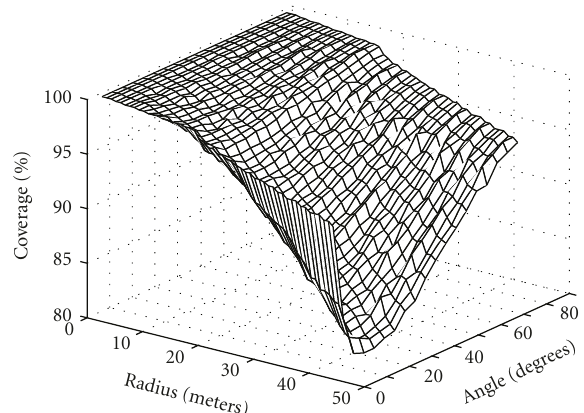
Figure 12: Uncertainty area for three receivers and r = R = 50m, as a function of the angle θ . , min